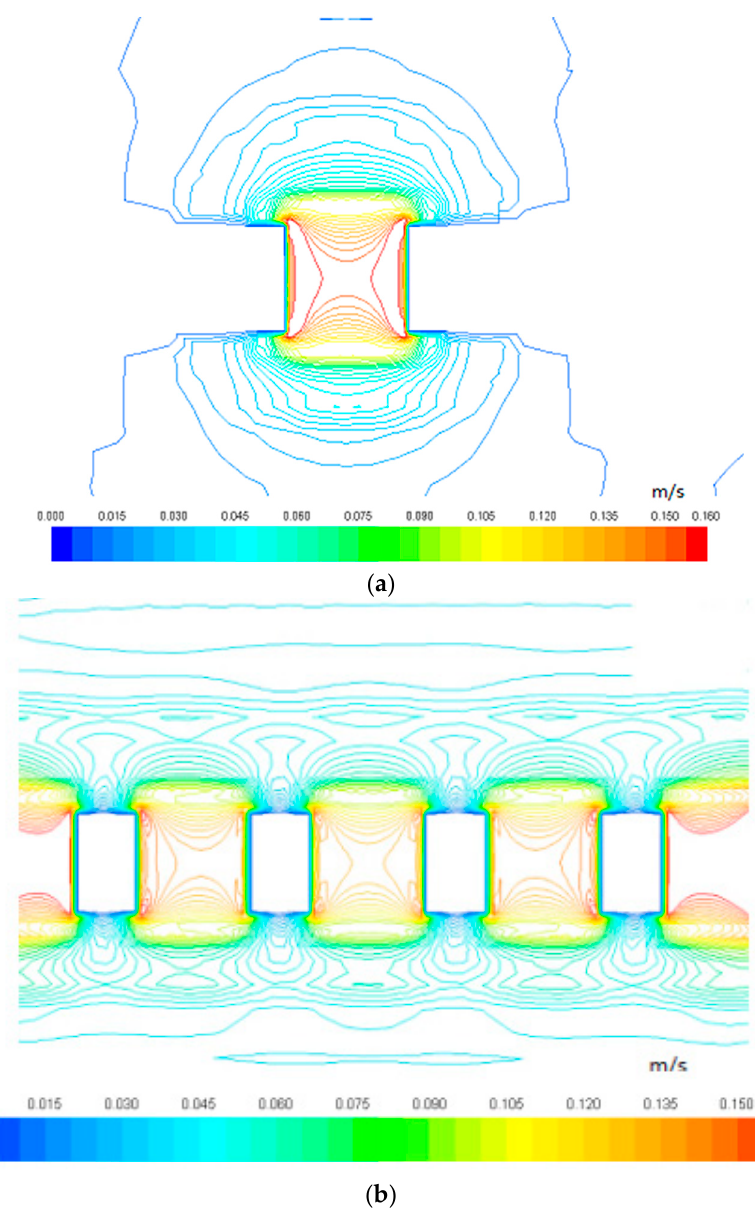
Figure 13. Acoustic velocity magnitude contour near an orifice with different hole separation distance: ( a ) plate No.7 absorber: x/d = 5, y/d = 5, ( b ) plate No.2 absorber: x/d = 1.5, y/d =